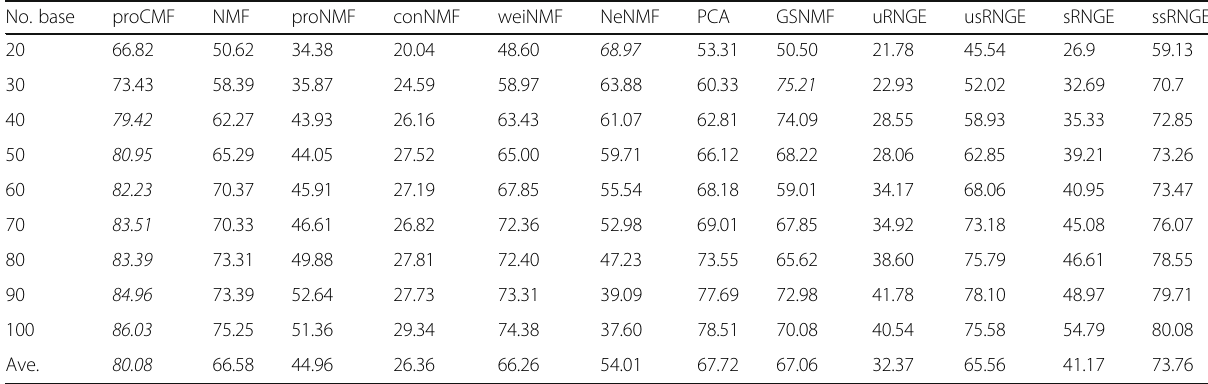
Table 5 Facial expression recognition rate (%) using the occluded CK+ with different subspace dimensionalities (case of occluded randomly